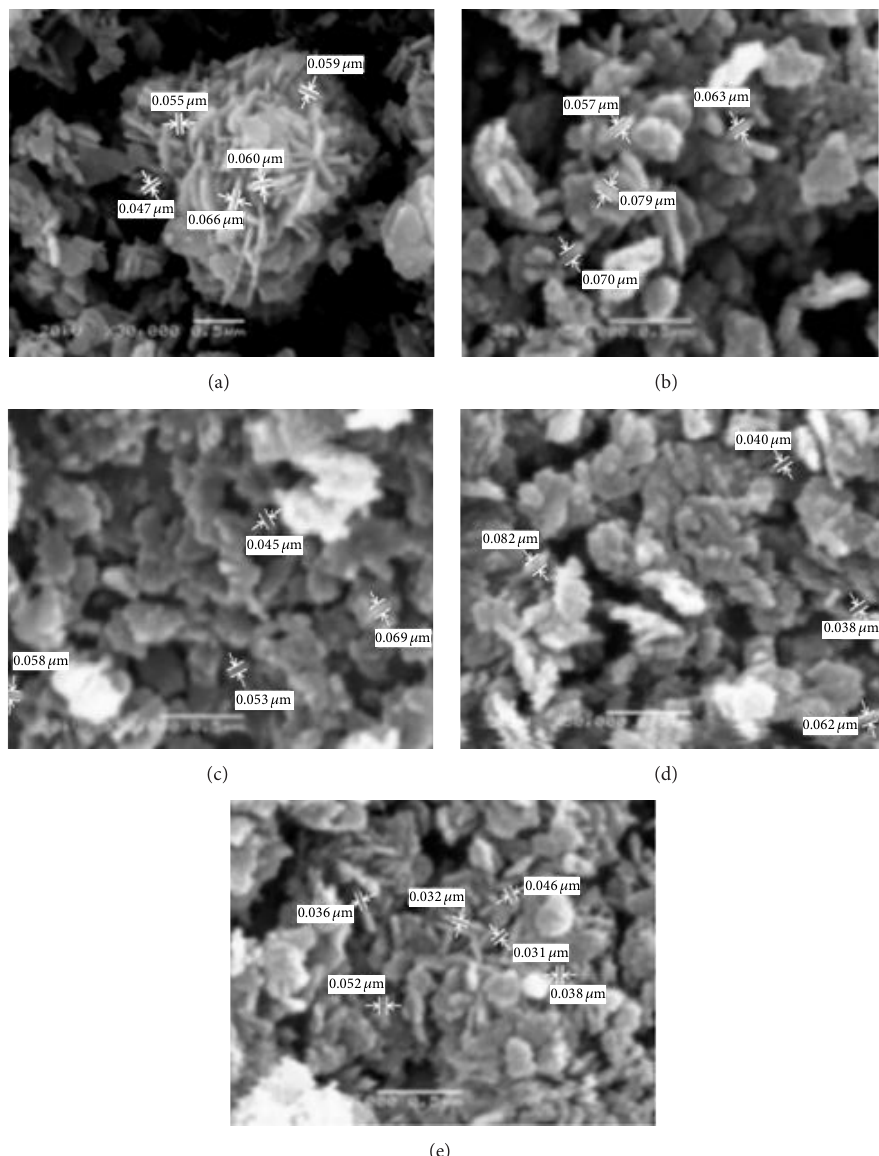
Figure 8: SEM micrographs of ZnO prepared using sol-gel technique with different reaction times: (a) 3 h, (b) 6h, (c) 12h, (d) 24 h, and (e) 48